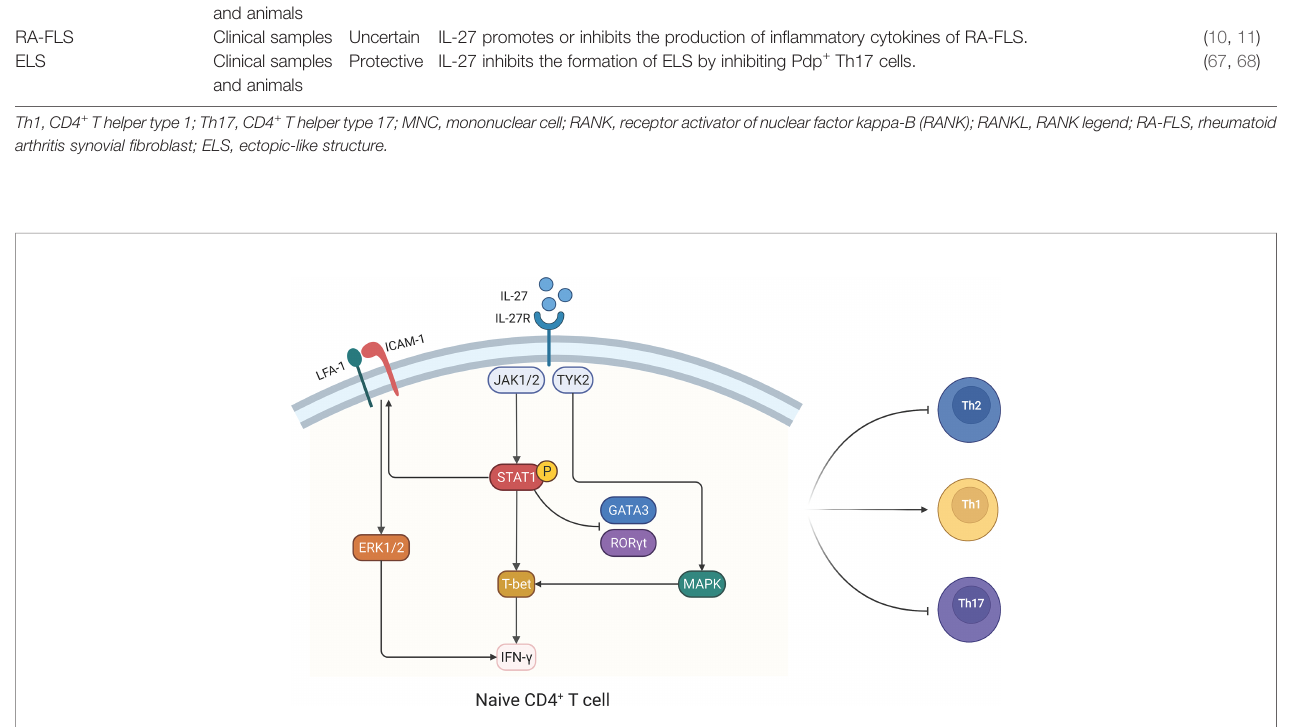
FIGURE 3 | Interleukin-27 (IL-27) promotes CD4 + T helper type 1 (Th1) cell differentiation and inhibits Th2 and Th17 cell development in CD4 + T cells. IL-27 promotes Th1 development via multiple signaling pathways. In CD4 + T cells, IL-27 binds to IL-27 receptor and activates Janus tyrosine kinase 1 (JAK1), JAK2, and tyrosine kinase 2 (TYK2). Subsequently, phosphorylated signal transducer and activator of transcription 1 (STAT1) activates T-bet, and this drives naive CD4 + T cell to skew toward Th1 cells. STAT1 phosphorylation also promotes Th1 development via leukocyte function-associated antigen 1 (LFA-1)/intercellular